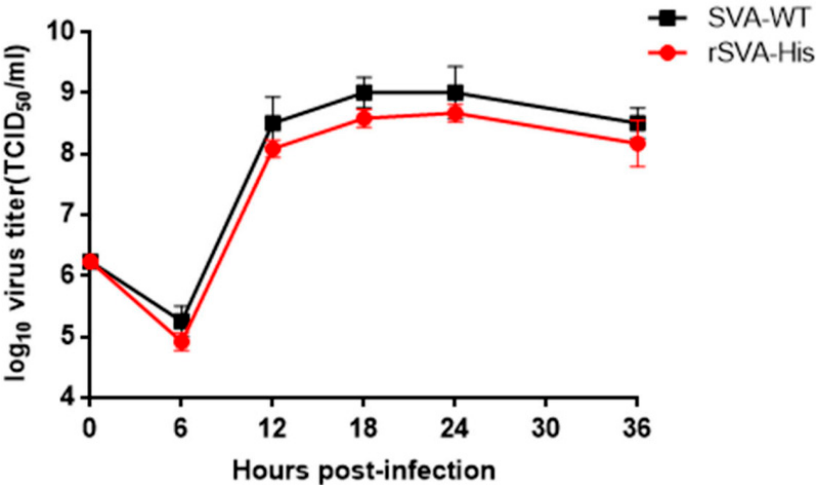
Figure 3. Growth curve of the rSVA ‐ His in BHK ‐ 21 cell. BHK ‐ 21 cells were infected with rSVA ‐ His and its parental virus. Samples were harvested at different time points post ‐ infection and the in ‐ fectivity titers were detected. Each data point represents the mean (±SD) of three wells.